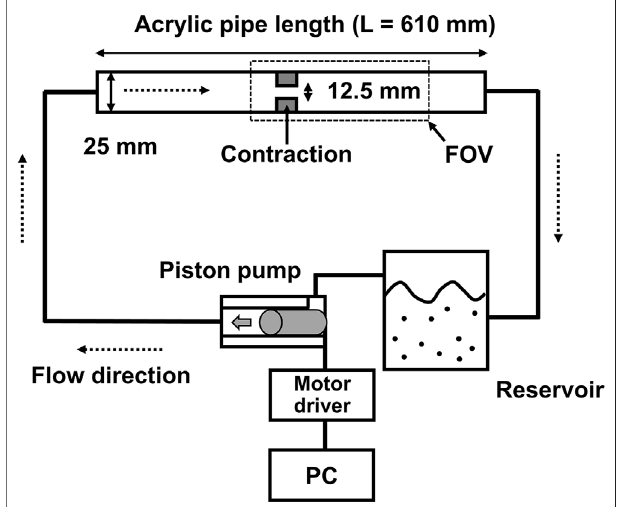
FIGURE 1 | A schematic for in-vitro